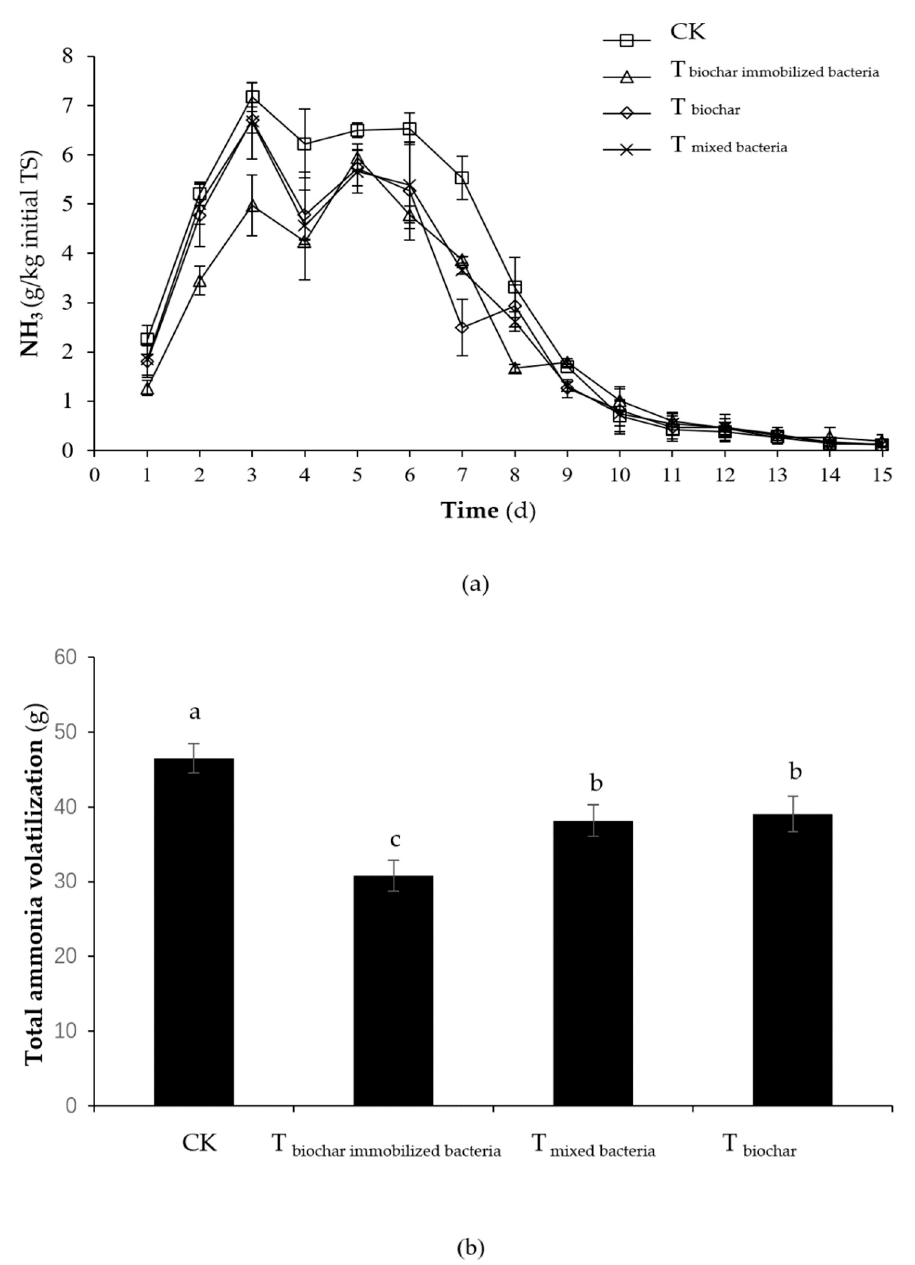
Figure 4. Changes in the NH 3 emissions in different composting treatments; Note: ( a ) NH 3 emission during the composting ( b ) total NH 3 emission (CK: as the control). Error bars represent the standard deviation ( n = 3); TS: total solid; a–c Columns reporting different letters are significantly different ( p < 0.05).